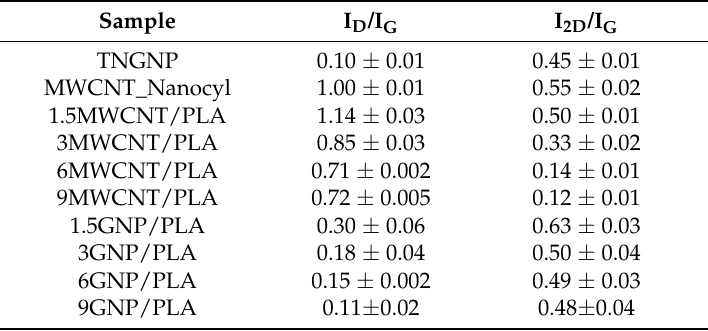
Table 2. Raman intensities ratios of monofiller nanocomposites.